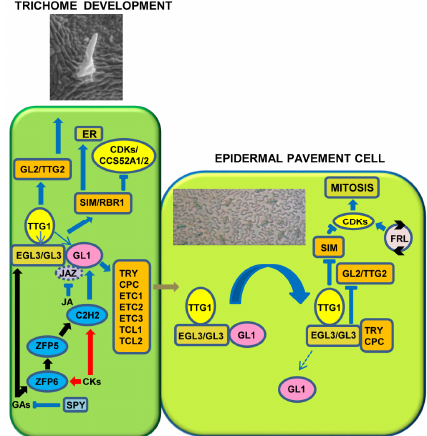
Figure 1. A simplified model for the acquisition of the competence of epidermal pavement cells to become trichomes in the model species Arabidopsis thaliana . In epidermal pavement cells, GLABRA3 (GL3) acts together with GLABRA1 (GL1) and TRANSPARENT TESTA GLABRA1 (TTG1), creating a trimeric MYB/bHLH/WD (MBW) activator complex. TTG1 works upstream of GL3 and GL1 , activating their expression (thin blue arrows). Gibberellins (GAs), cytokinins (CKs), and jasmonic acid (JA) contribute positively to the regulation of trichome development. GAs activate the transcription of the ZINC FINGER PROTEIN 6 ( ZFP6 ) gene, a member of the large C2H2 regulatory gene family (black arrow). ZFP6 induces the expression of ZFP5, and then ZFP5 promotes GLABROUS INFLORESCENCE STEMS ( GIS ) ( C2H2 ), GIS2 , and ZFP8 expression (black arrows). At the same time, CKs promote ZP6 , ZFP8 , and GIS2 expression (red arrows). C2H2 members (i.e., GIS2 and ZFP8 ) increase the transcription of GL1 (blue arrow). The transcription levels of GL3 , TTG1 , and TRY are regulated by GAs (in the figure a single black arrow indicates the activation of the MBW complex). The SPINDLY ( SPY ) gene inhibits the GA signal (blue inhibitory line). JA regulates the formation of trichomes, favoring the degradation of proteins of the Jasmonate ZIM-domain (JAZ) (blue inhibitory line and blue dotted line); therefore, this hormone inhibits the interaction between JAZ with GL1 and EGL3/GL3 transcription factors (TFs). The MBW complex stimulates the development of trichomes, switching the transcription of several targets (represented by orange boxes): (i) SIAMESE ( SIM ) and RETINOBLASTOMA RELATED1 ( RBR1 ) as key genes in cell cycle regulation (blue arrow); (ii) GL2 and TTG2 as positive regulators (blue arrow); and (iii) R3-MYB TFs (CAPRICE (CPC), TRYPTICON (TRY), ENHANCER OF TRY AND CPC1 (ETC1), ETC2, ETC3, TRICHOMELESS1 (TCL1) and TCL2) as repressors of trichome initiation and growth (blue arrow). SIM and RBR1 promote the trichome initiation from epidermal pavement cells through the down-regulation of some cyclin-dependent kinases (CDKs) and the CELL CYCLE SWITCH 52A1 ( CCS52A1 ) and CCS52A2 genes, respectively (blue inhibitory line). Therefore, the conversion of a normal mitosis into the endoreduplication cycle (ER) is promoted (blue arrow). The R3-MYB inhibitors are capable of movement in adjacent cells (grey arrow) and replace GL1 in the MBW complex (bent and dotted blue arrows) to form a repressor complex, which cannot promote GL2 and TTG2 expression (blue inhibitory line), thereby inhibiting trichome fate. The repressor complex also loses ability to activate the target SIM gene (blue inhibitory line). A complex feedback regulatory loop (FRL, pink circle with black arrowheads), including, among other inhibitors of CDKs such as KIP-RELATED PROTEINS (KRPs) and SIM, RBR1 and E2F, TFs activate (blue arrow) some CDKs allowing cells entry into the mitotic cycle (blue arrow). TFs: transcription factors.